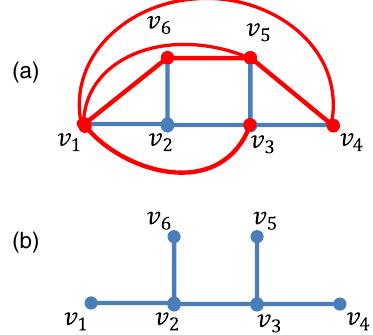
FIG. 6. (a) Exemplary graph. Red edges correspond to private capacity 1 and blue to private capacity 2. The first strategy for obtaining the conference key uses a vertex connected to all others ∶ ð v and reaches the suboptimal rate min f w ð e 1 ; v 6 Þ ; ð v 1 ; v 5 Þ ; ij Þ ð v 1 ; v 4 Þ ; ð v 1 ; v 3 Þ ; ð v 1 ; v 2 Þg ¼ 1 . The same happens for any path, which inevitably has to pass through some red edge. The solution is a tree, which is a spanning tree of this graph, and it contains no red edge (b). Traversing the edges of this tree is equivalent to the breadth-first